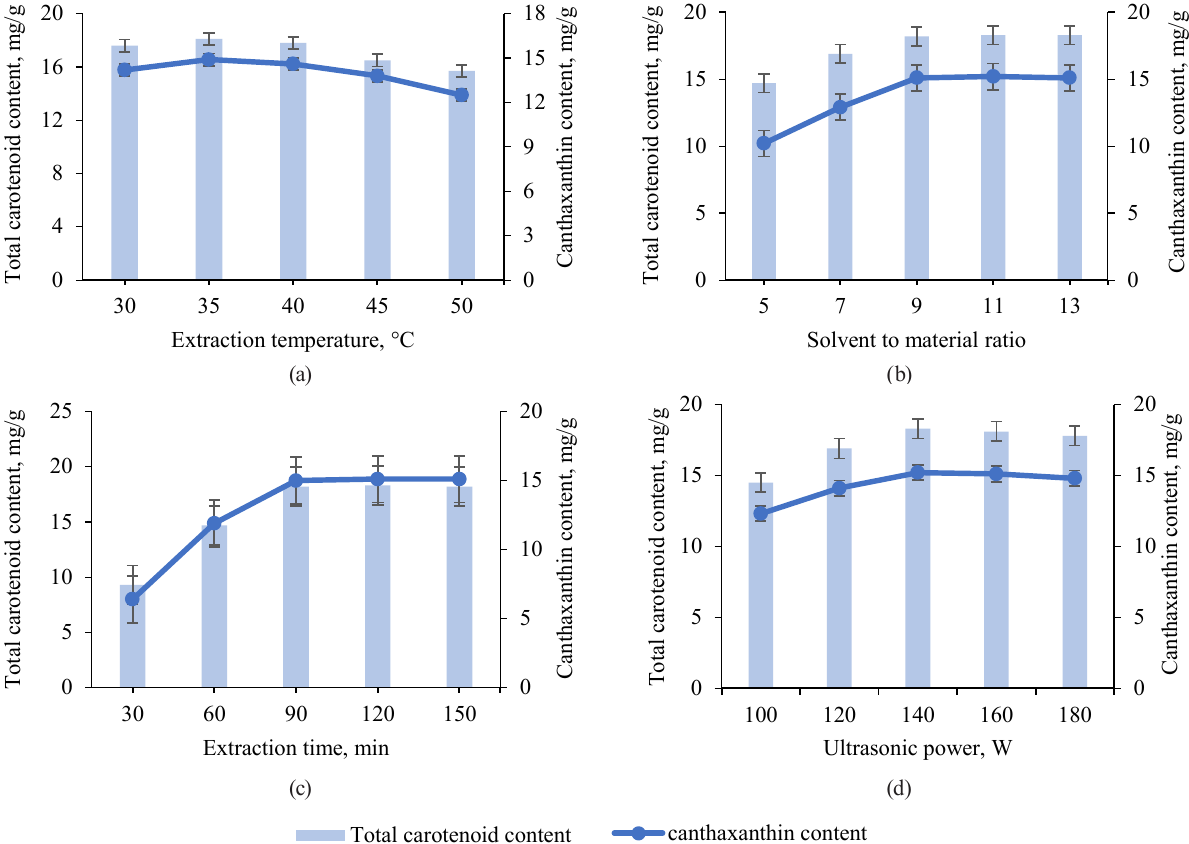
Figure 2 Effect of extraction temperature (a), solvent/material ratio (b), extraction time (c), and ultrasonic power (d) on the total carotenoid content and canthaxanthin content from dried